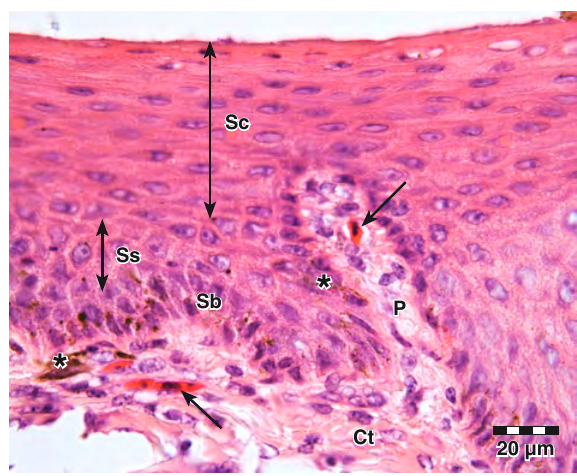
FIG. 5 Pseudostratified ciliated columnar epithelium (white stars) lining part of the lumen (L) of a large, simple branched tubular gland. Note the basophilic cytoplasm (Cy) of the adjacent mucus­secreting cells and their basally­positioned, dark flattened nuclei ( * ). Cilia (arrows)